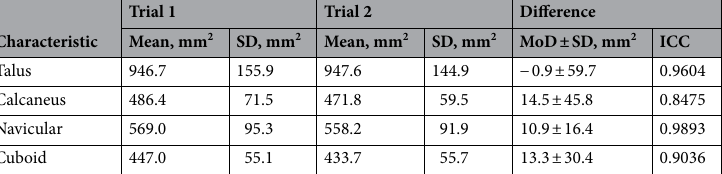
Table 4. Intraclass correlation coefficient for selected regions, determined from area of regions. ICC intraclass correlation coefficient, MoD mean of differences, SD standard deviation.